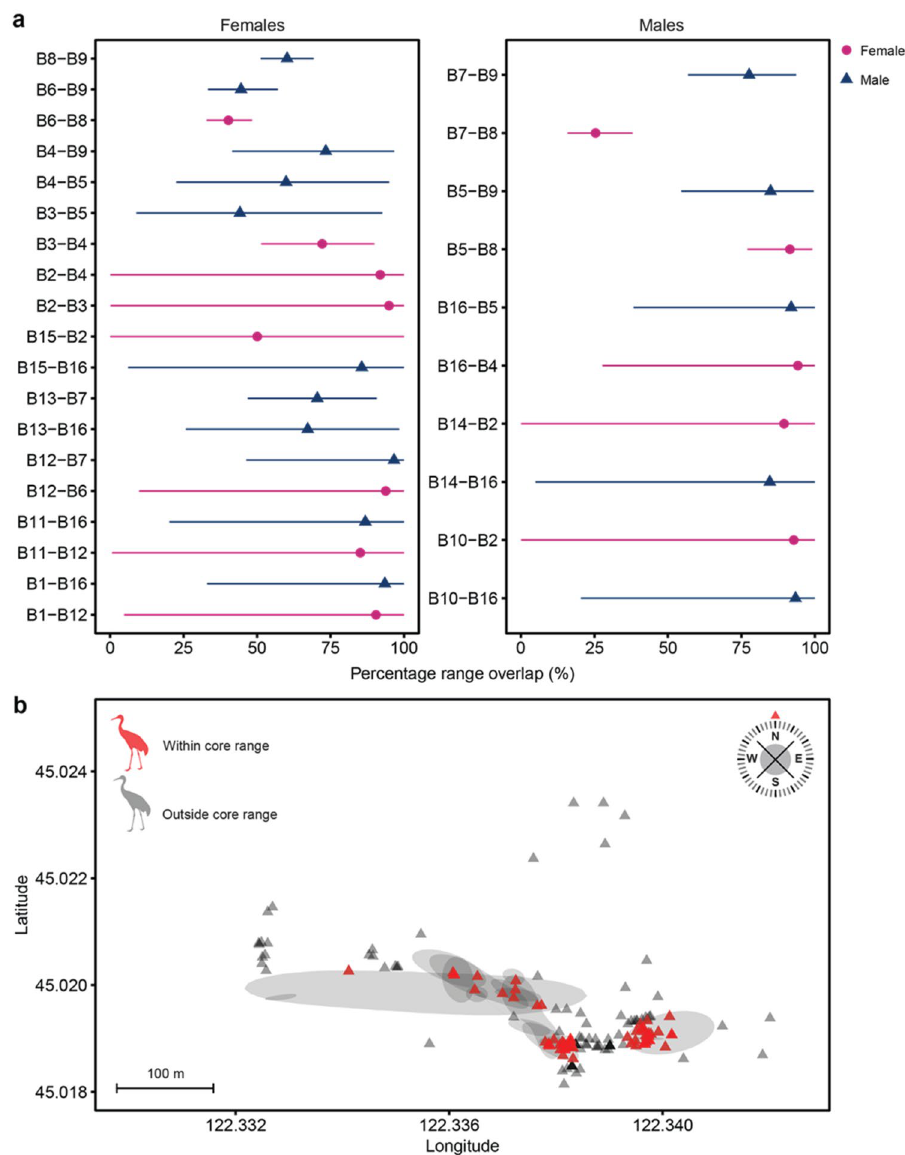
Figure 2. ( a ) The top two pairwise overlap estimates (± 95% confidence intervals) based on the Bhattacharyya coefficient for each Elaphe dione (left plot females, right plot males). Purple circles represent an individual paired with a female, while blue triangle represent an individual paired with a male. Results for all possible pairs of individuals in Table S3. ( b ) The degree of Grus japonensis sightings overlapping with the E. dione 50% active range (filled contours). Red riangles represent G. japonensis sightings in the core activity space, while black triangles represent Grus japonensis outside the activity